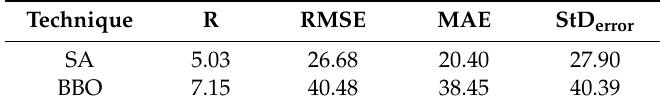
Table 4. Increase of performance index Inc (in %) using hybrid models. Technique